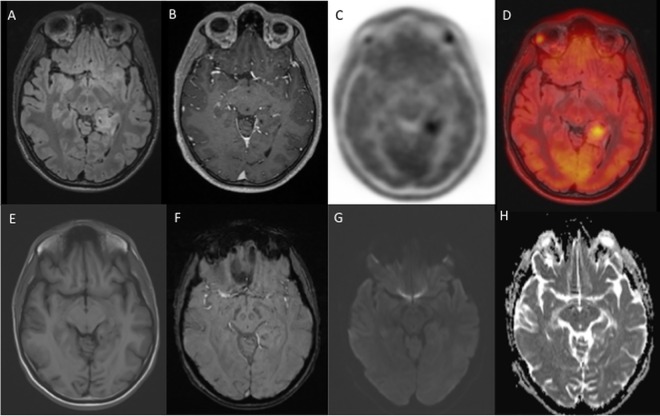
Astrocytoma grade II.21-year old male patient with a left sided temporomesial, blurry demarked FLAIR-hyperintens lesion (A), without contrast-enhancement (B), but with focal methionine uptake (SUVmax 1.5, T/N ratio 1.9) (C, D (PET-fusion image with FLAIR-images)). No correlate of the lesion was found in native T1w (E), SWI (F), DWI-b1000 (G) and ADC-images (H). 10 months after initial methionine PET/MRI a progress from a formerly astrocytoma °2 to a high-grade glioma was suspected and operation finally revealed a histopathologically confirmed GBM.